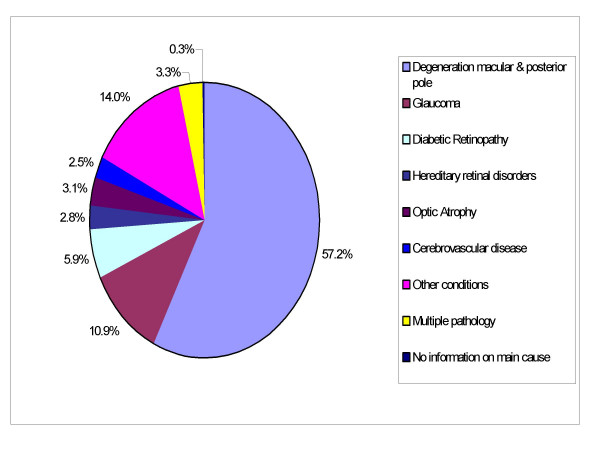
Causes of certifications for blindness in England and Wales April 1999 – March 2000.